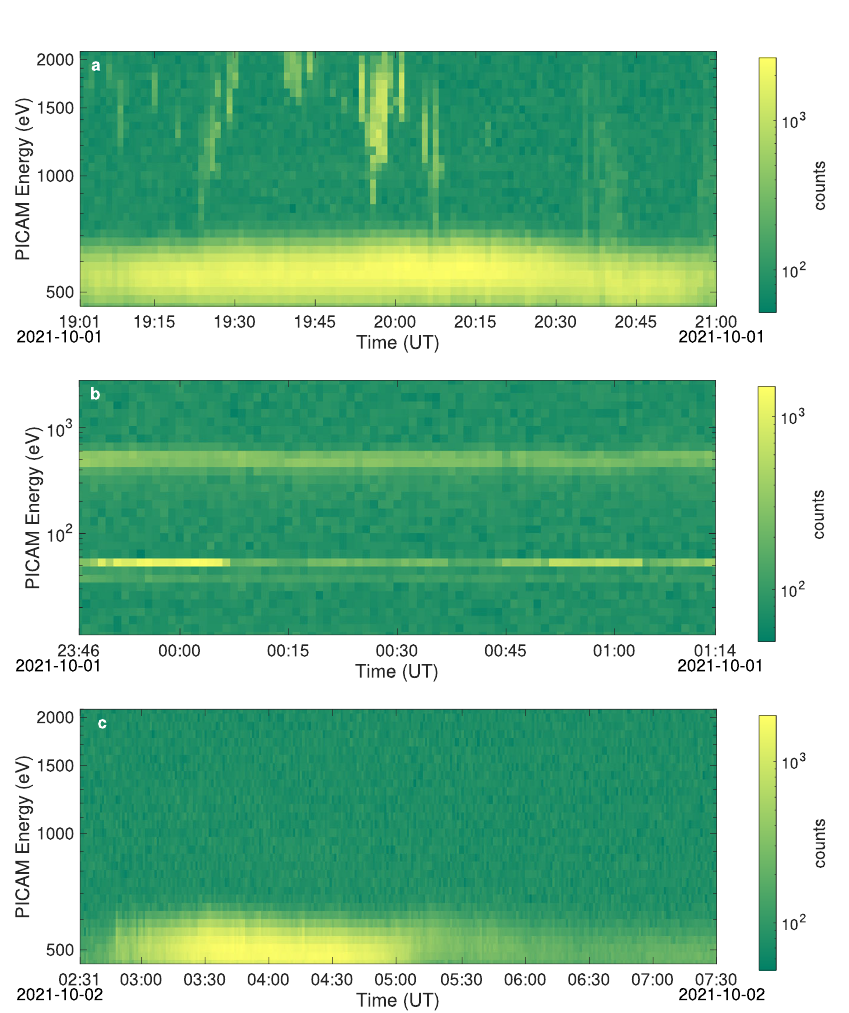
Fig. 4 | MFB1 PICAM spectrograms outside Mercury ’ s magnetosphere. The spectrograms obtained by PICAM observations during the different time intervals: a from19:01UTto21:00UTonthe1stofOctober,2021, b from23:46UTonthe1st